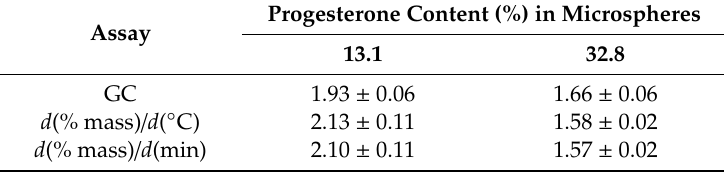
Figure 6. Amounts of residual ethyl formate in PLGA microspheres with different progesterone payloads. The first derivatives of a TG curve with respect to degrees Celsius and minutes were employed to calculate the content of residual ethyl formate. Table 3. Comparison of the contents (%) of residual ethyl formate in PLGA microspheres determined by DTG and GC.